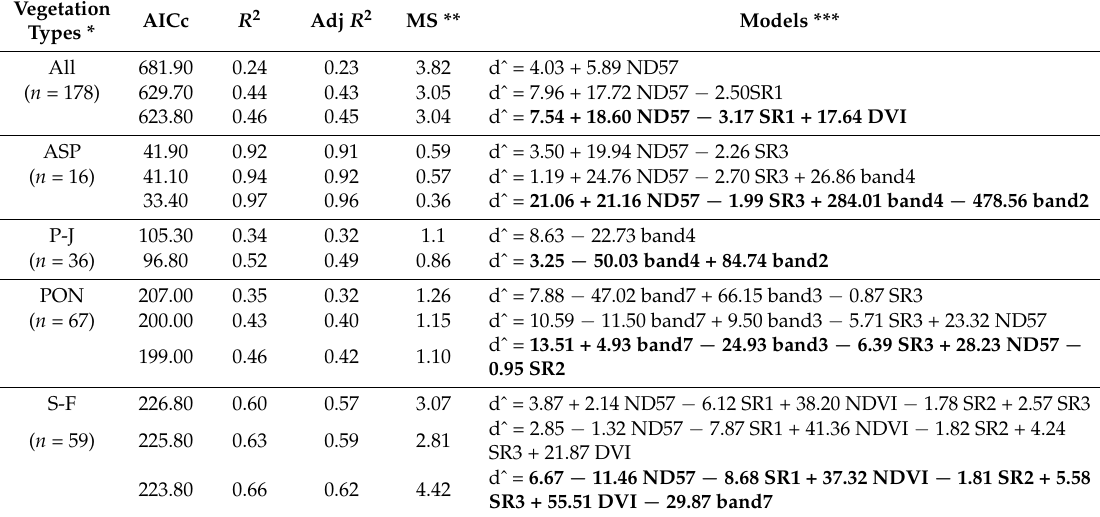
Table 1. Corrected Akaike Information Criteria (AICc), R 2 , adjusted R 2 , and mean square error (MS) for the multiple regression models between density and combination of bands and vegetation indices for the entire area and for each vegetation type. Intercept and coefficients refer to the regression models used in the prediction. The values in bold show the best models